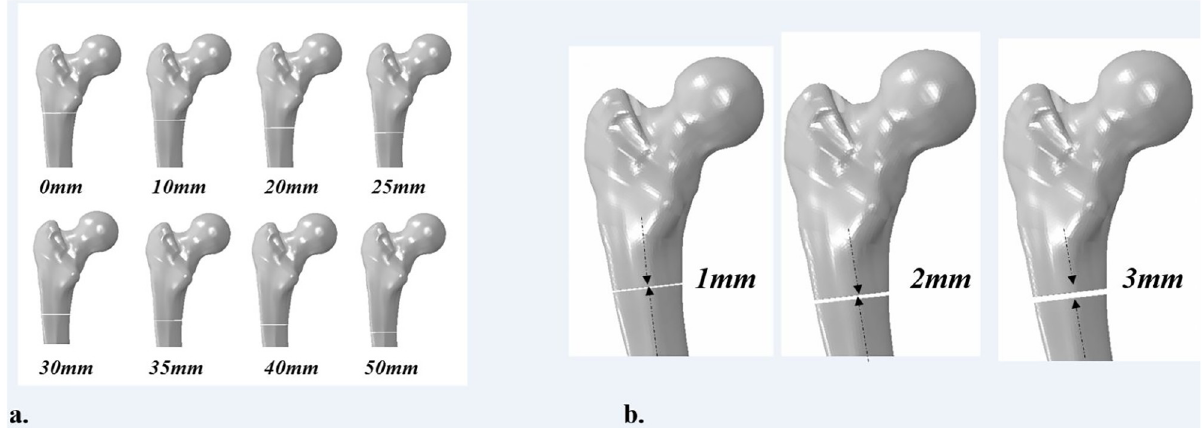
Fig 1. Finite element models with transverse subtrochanteric fracture of different fracture